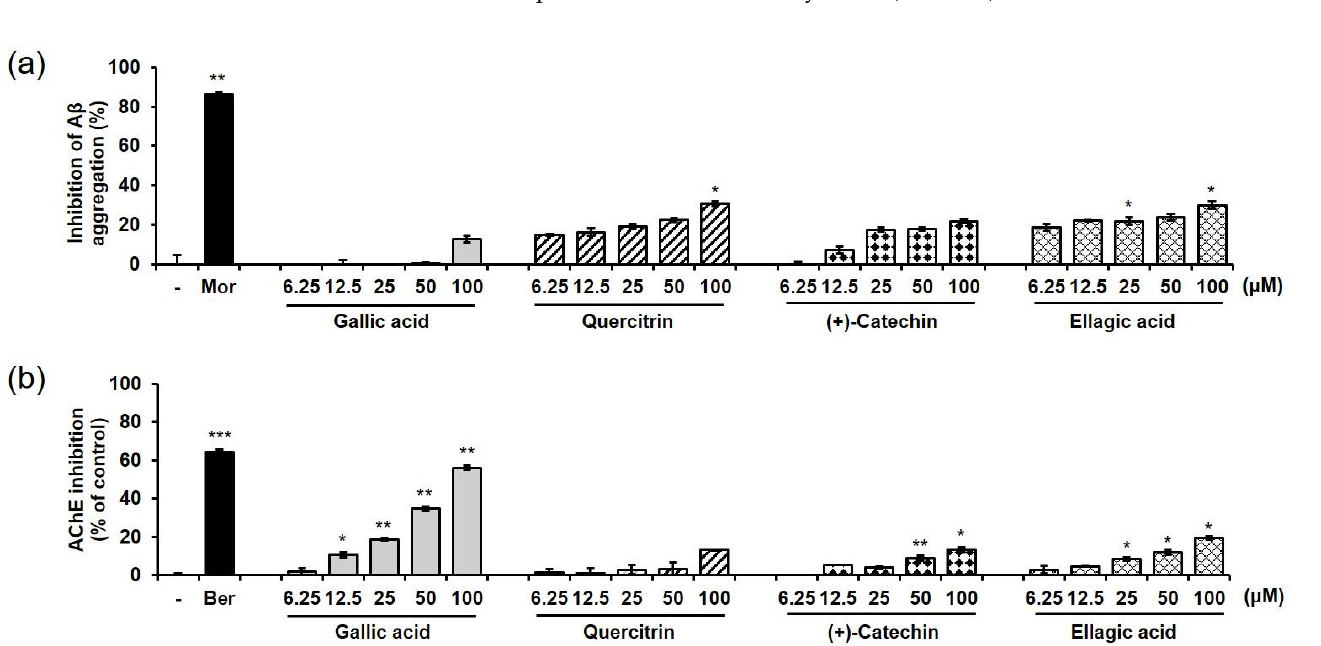
Figure 5. Effects of marker EEBC compounds on A β aggregation and AChE activity. ( a ) For the in vitro A β aggregation assay, gallic acid, quercitrin, (+)-catechin, and ellagic acid (6.25, 12.5, 25, 50, or 100 µ M) were mixed with A β (1–42), followed by the addition of 10 µ L of thioflavin T dye. Fluorescence of thioflavin T was measured at intervals of 20 min for 2 h, with an excitation wavelength ( λ ex ) of 440 nm and an emission wavelength ( λ em ) of 485 nm on a SpectraMax i3 Multi-Mode Detection Platform. Morin (100 µ M) was used as the positive control; ( b ) For the in vitro AChE activity assay, gallic acid, quercitrin, (+)-catechin, and ellagic acid (6.25, 12.5, 25, 50, or 100 µ M) were mixed with the substrates, acetylthiocholine iodide and DTNB, and incubated for 10 min at room temperature. AChE solution was then added to the initial mixture and additionally incubated for 1 h at room temperature. Absorbance was measured at 412 nm using an Epoch microplate spectrophotometer. Berberine (0.5 µ M) was used as the positive control. Each value is presented as the mean ± SEM. * p < 0.05, ** p < 0.01, or *** p < 0.001 vs. control. EEBC: ethanol extract of B. coccinea branches. A β : amyloid- β . AChE: acetylcholinesterase. DTNB: 5,5 (cid:48) -dithiobis-2-nitrobenzoic